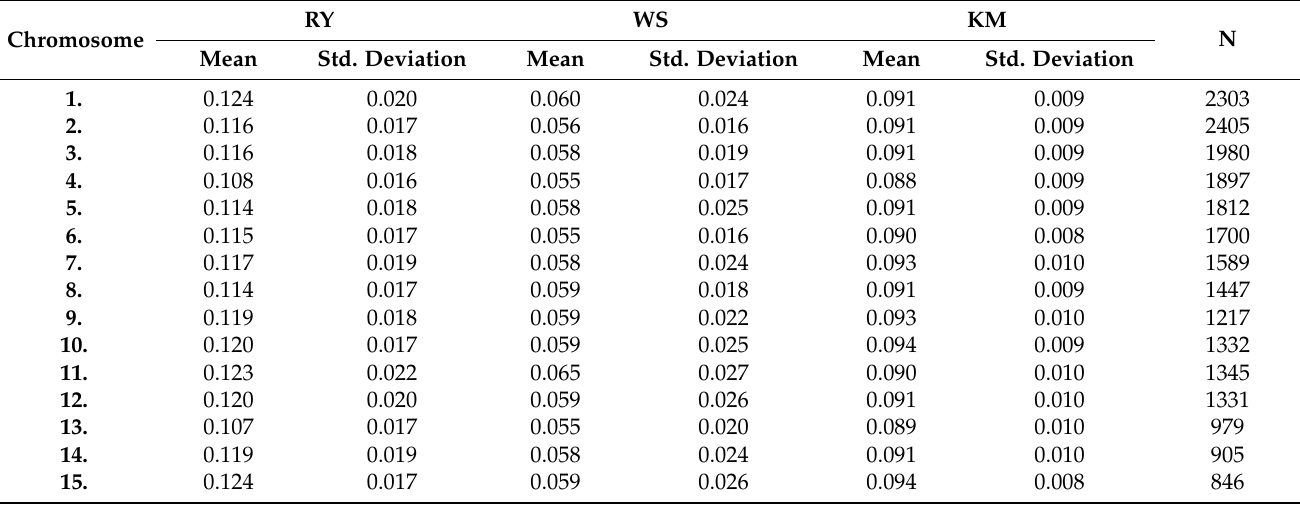
Table A2. Descriptive statistics of distance from randomness (relative abundance profile) analysis for each